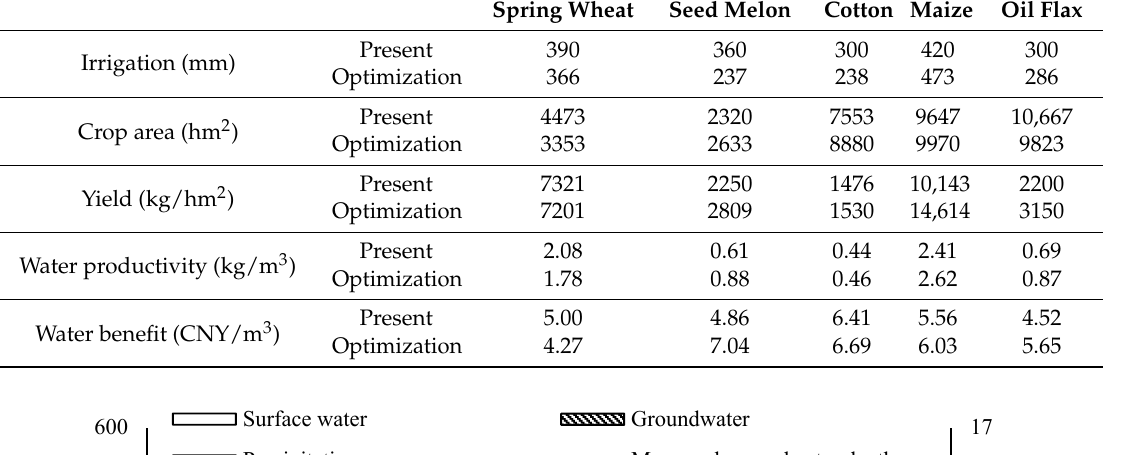
Table 6. Comparison of the indicators before and after optimization.